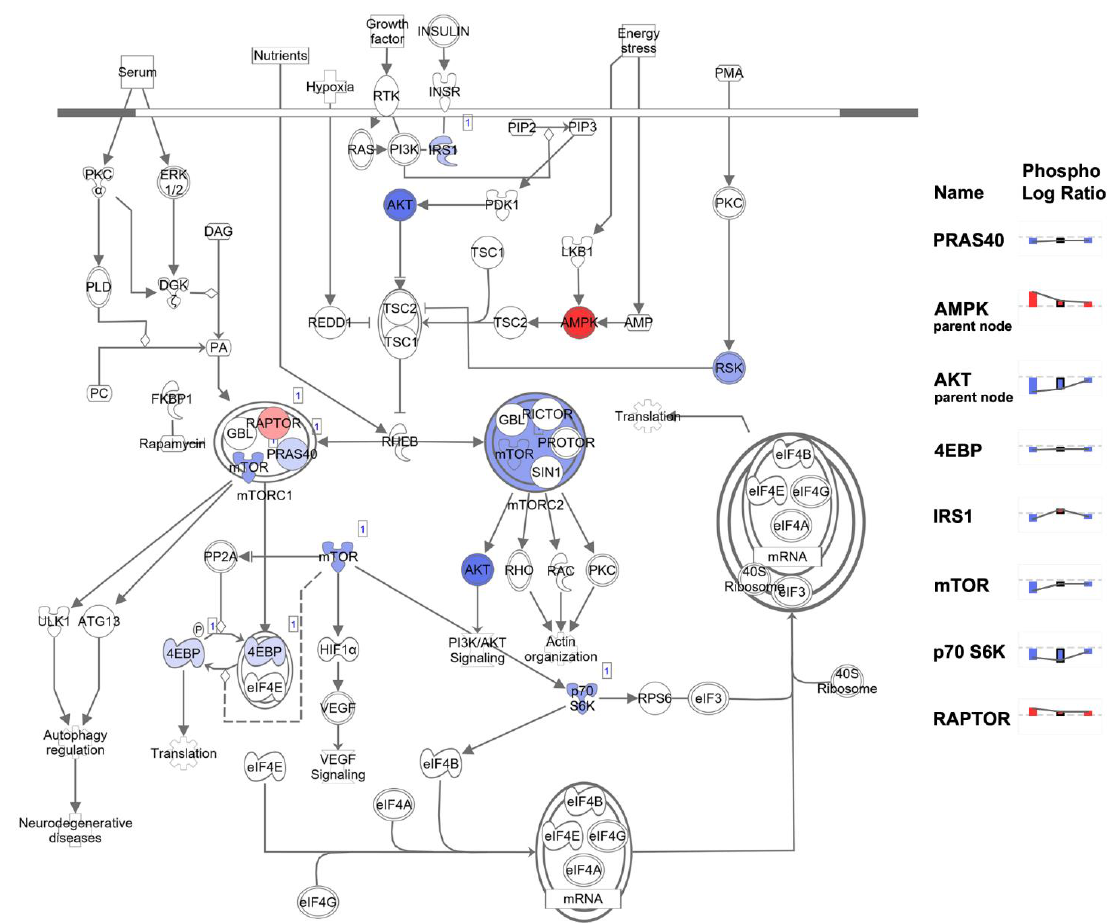
Figure 9. Effect of 4-oxo-DHA on the mTOR signaling pathway was diagrammed in IPA and corre- sponding expression data from the BT474 cell line was overlaid on the pathway. Overlaid expres- sion is shown as the ratio of phosphorylated to total protein. The chart on the right shows the ex- pression of major regulatory nodes of the mTOR signaling pathway while illustrating a pattern of differential regulation across the cell lines BT474, SRBR3, and MDAMB464, respectively. Red indi- cates protein activation and blue indicates